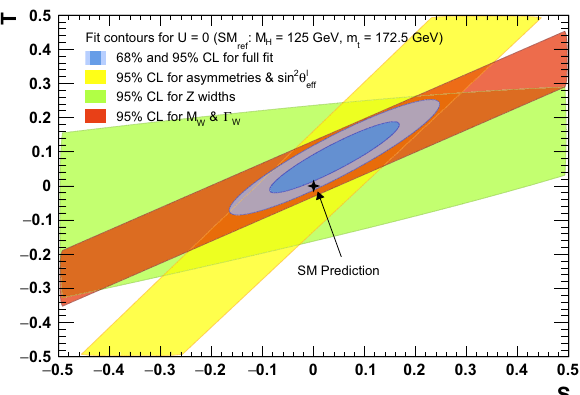
Fig. 7 Constraints in the oblique parameters S and T , with the U parameter fixed to zero, using all observables (blue). Individual con- straints are shown from the asymmetry and direct sin 2 θ (cid:3) ments (yellow), the Z partial and total widths (green) and W mass and width (red), with confidence levels drawn for one degree of freedom